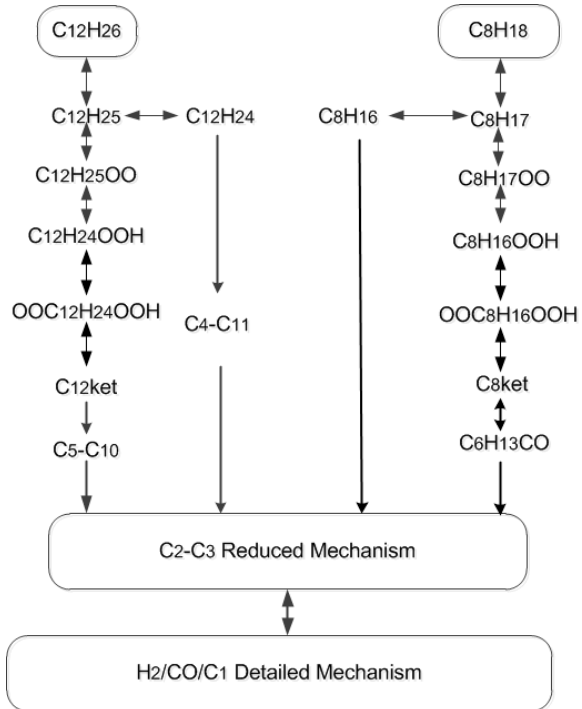
Figure 5. Main reaction path of F–T fuel surrogate model skeletal Figure 5. main reaction path of F–T fuel surrogate model skeletal mechanism.